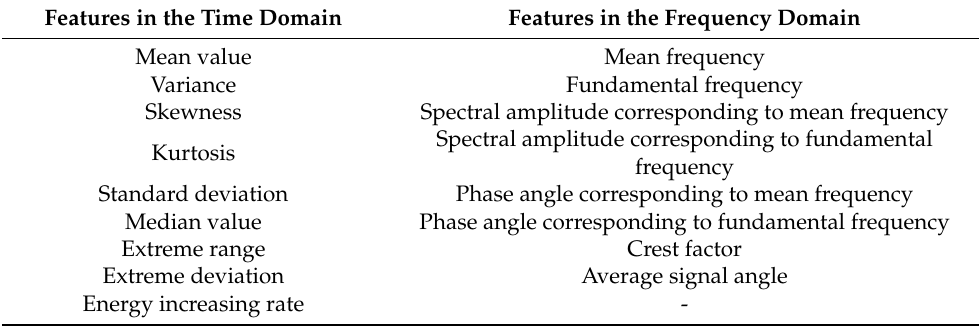
Table 3. Manual features for training kNN and SVM models.